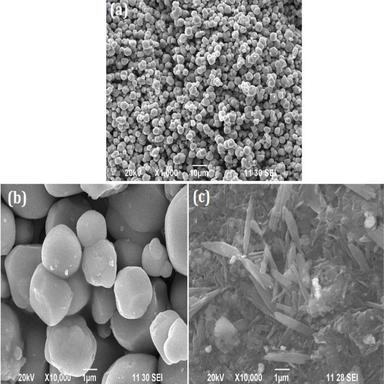
SEM images of powder of (a) PMA, (b) PMAA and (c) PMAB hybrid materials.